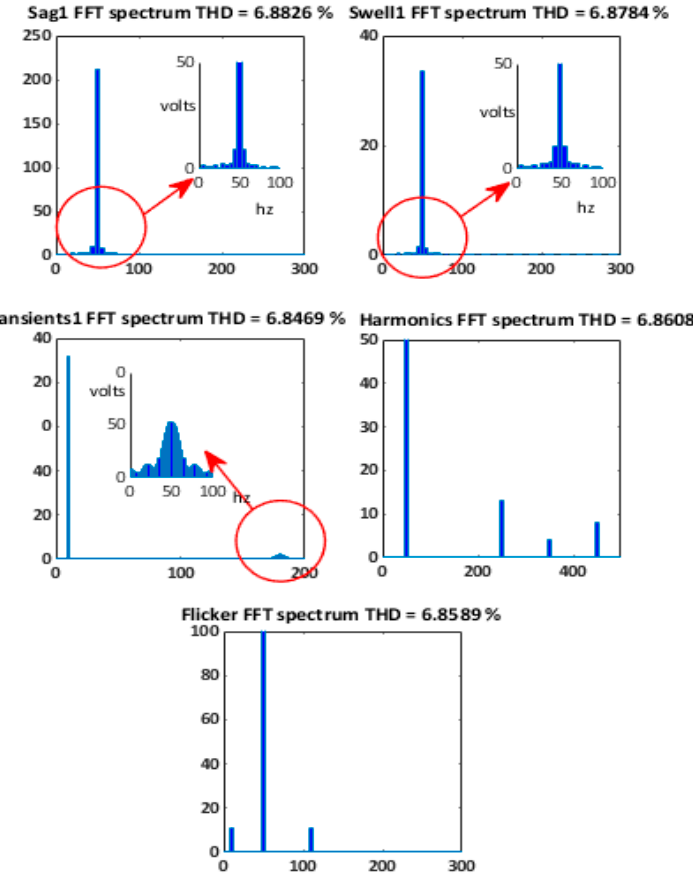
Figure 6. FFT spectra for several signals used on case A.